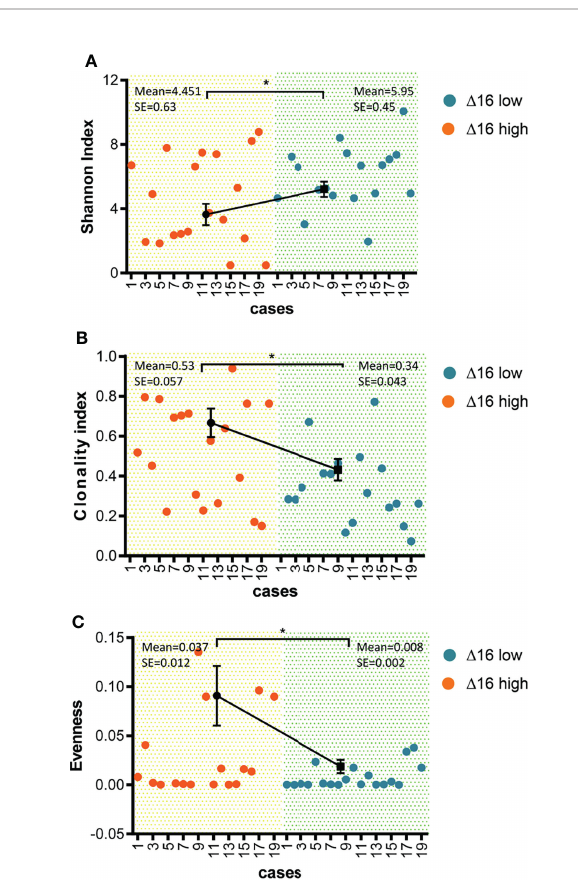
FIGURE 4 | Reduced diversity of TCR clones in ERBB2d16-high patients. (A) Shannon index was lower in the ERBB2d16-high patients (n = 20) compared with the ERBB2d16-low patients (n = 20). (B) Clonality index was higher in the ERBB2d16-high patients (n = 20) compared with the ERBB2d16-low patients (n = 20). (C) Evenness index was higher in the ERBB2d16-high patients (n = 20) compared with the ERBB2d16-low patients (n = 20). (*p < 0.05, **p < 0.001, ***p < 0.0001). D 16 low: ERBB2d16/ERBB2 ratio < 0.88; D 16 high: ERBB2d16/ERBB2 ratio ≥ 0.88. ERBB2: human epidermal growth factor receptor-2; ERBB2d16: ERBB2 D Ex16; TCR: T cell receptor